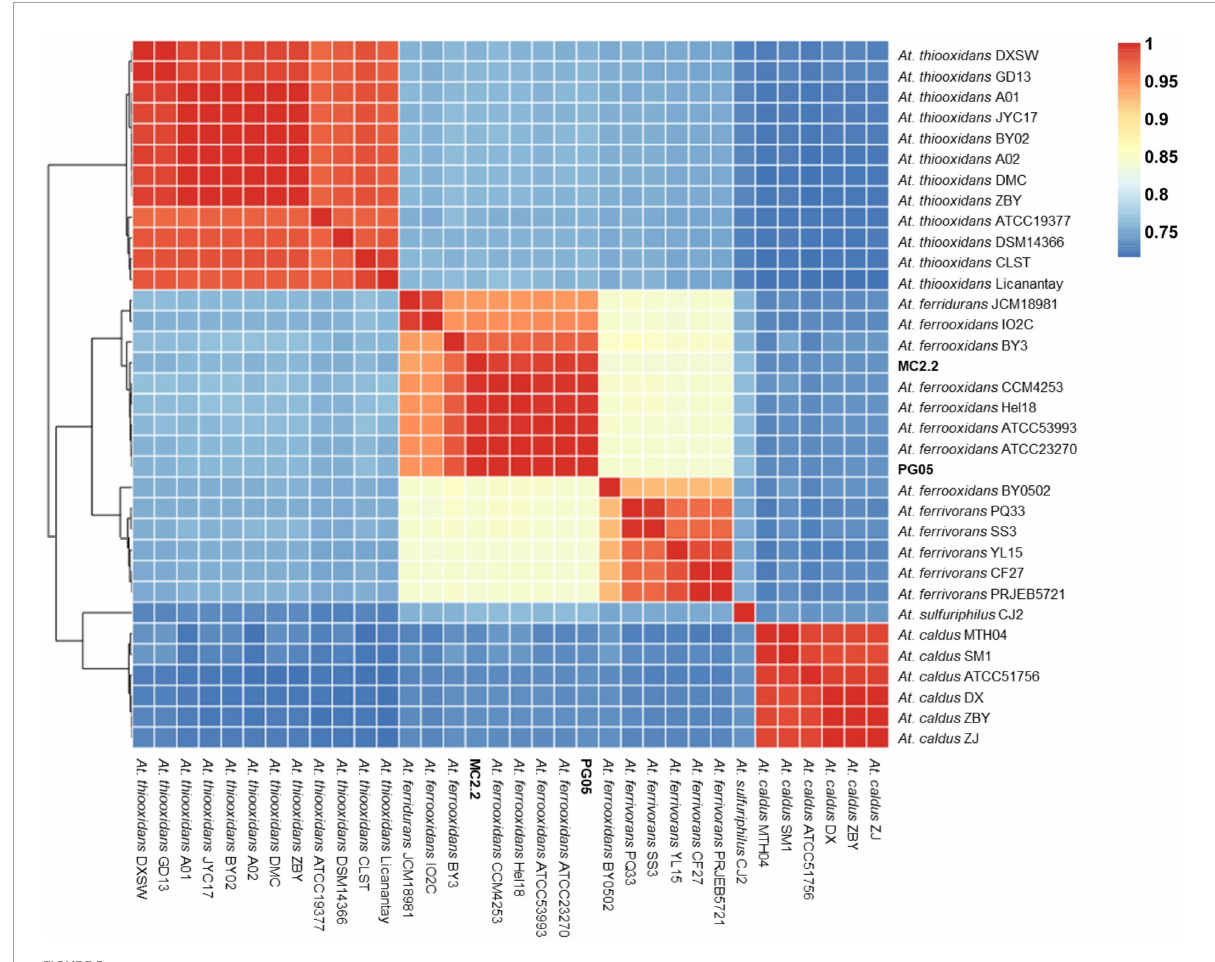
FIGURE5 Whole genome nucleotide identity and multi-locus phylogenetic analysis. Average nucleotide identity (ANI) in the 32-genome Acidithiobacillus